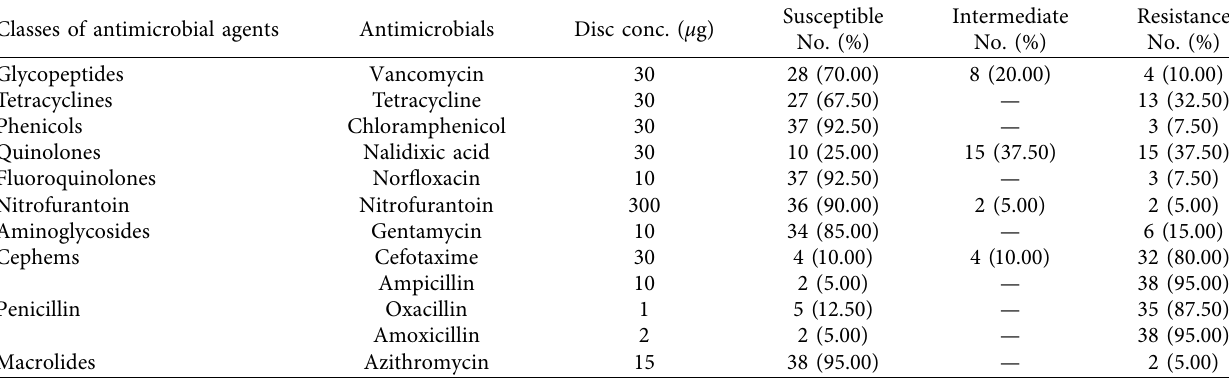
Table 7: Antimicrobial resistance profiles of S. aureus from milk and milk products ( n � 40). Classes of antimicrobial